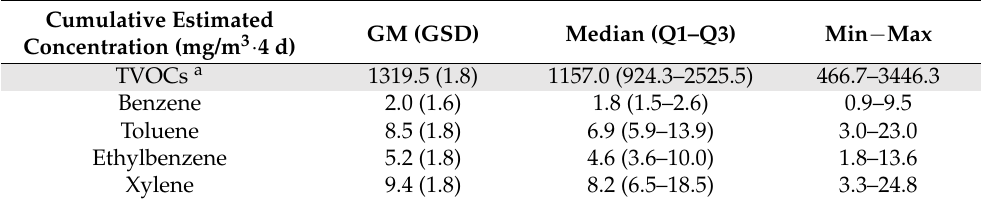
Table 2. Cumulative estimated concentrations of atmospheric total volatile organic compounds (TVOCs), benzene, toluene, ethylbenzene, and xylene over the first 4 days after the exposure to VOCs from the Hebei Spirit oil spill.